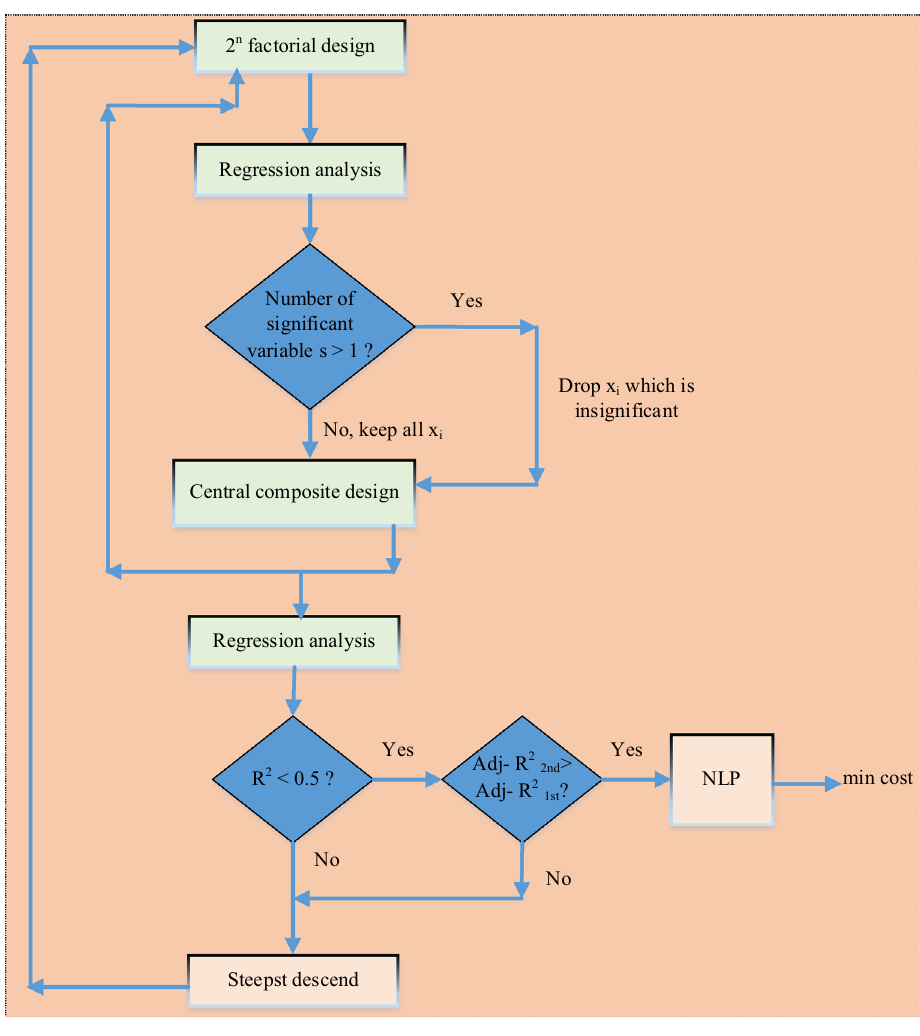
Figure 2. The scheme of study for